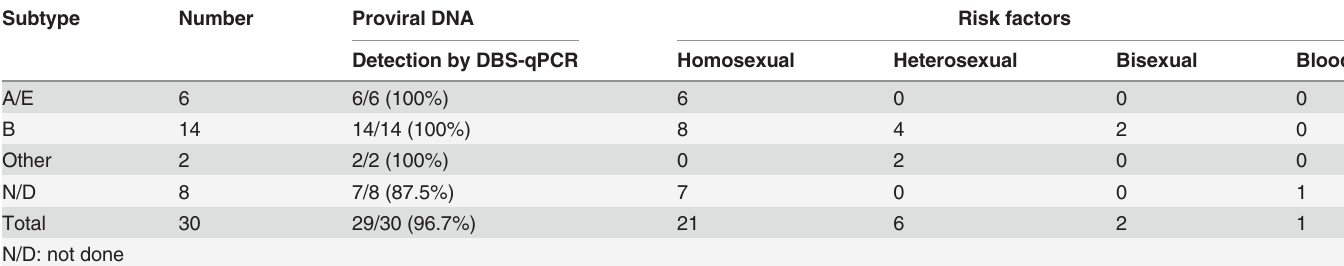
Table 1. HIV-1 genetic diversity and detection of pro-viral HIV-1 DNA using SYBR Green Real-Time PCR assays.